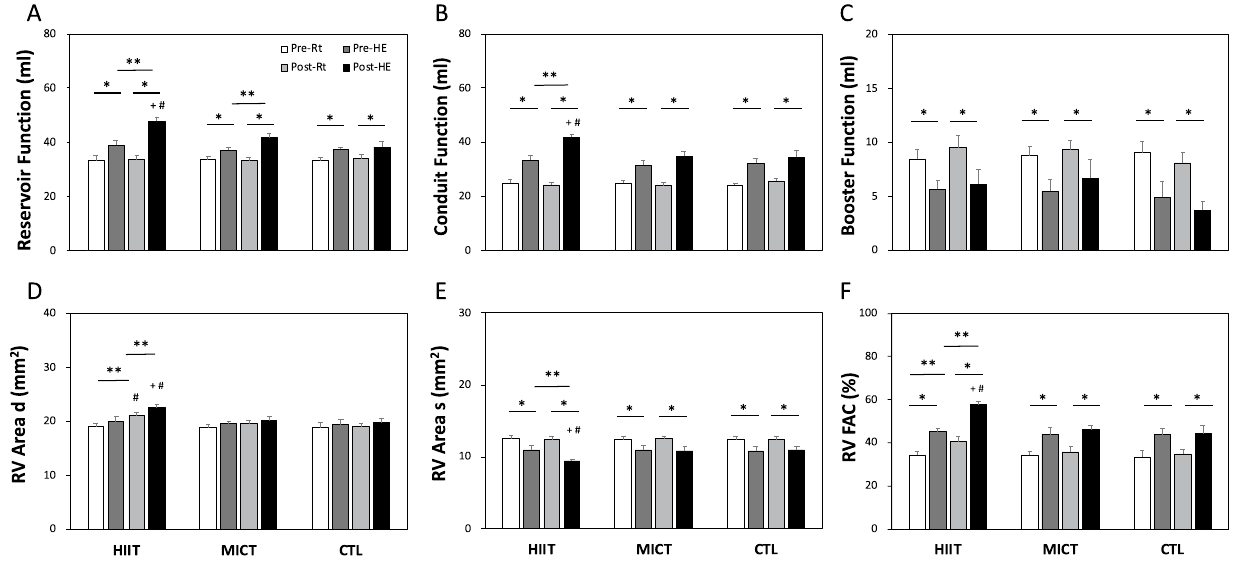
Figure 1. Comparisons of the effects of various exercise regimens on RA volumes and RV area parameters at rest or during HE. ( A ) Reservoir function; ( B ) Conduit function; ( C ) Booster function; ( D ) RV area in end-diastole; ( E ) RV area in end-systole; ( F ) RV fractional area change (FAC). HIIT, high-intensity interval training group; MICT, moderate-intensity continuous training group; CTL, control group; Pre-Rt,